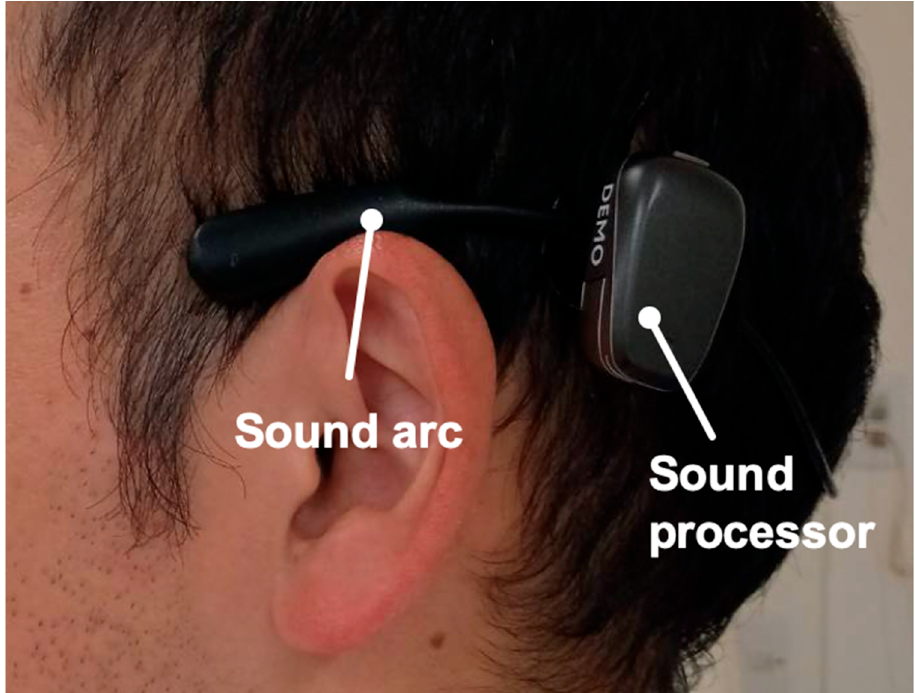
Figure 3. Example of an ear with a Bone anchored hearing aid (Baha). Profile views (left side) of a patient fitted with a Baha. The sound arc is designed to sit above the ears and be worn behind the head with a sound processor.